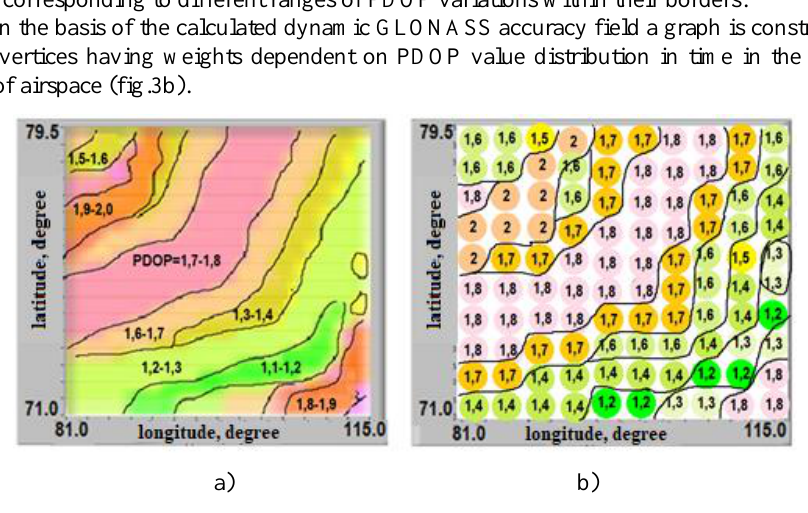
Fig.3. Representation of a GLONASS accuracy field as a